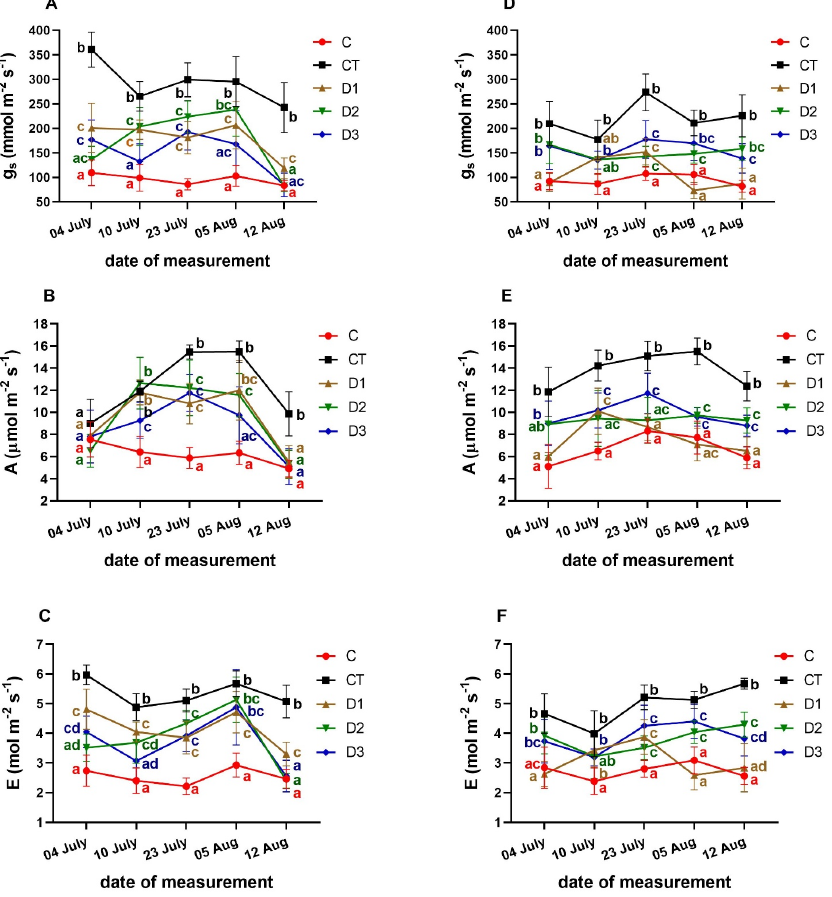
Figure 3. ( A − F ) Effects of treatments on gas exchange parameters on Chardonnay ( A − C ) and Kékfrankos ( D − F ) varieties in 2013: g s (mmol m − 2 s − 1 ) − stomatal conductance ( A , D ), A (µmol CO 2 m − 2 s − 1 ) − assimilation rate ( B , E ), and E (mol H 2 O m − 2 s − 1 ) − transpiration rate ( C , F ) during the growing seasons. Each symbol represents the mean value ± standard deviation (SD). Significance groups of each measurement date are marked with letters ( p < 0.05). The color of the letters corresponds to the color of the treatments.